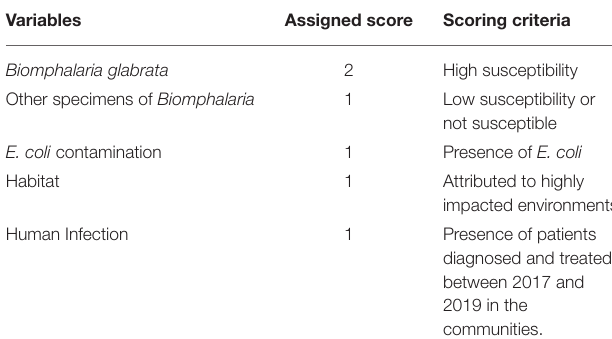
TABLE 1 | Arbitrary score sheet of the variables obtained in the